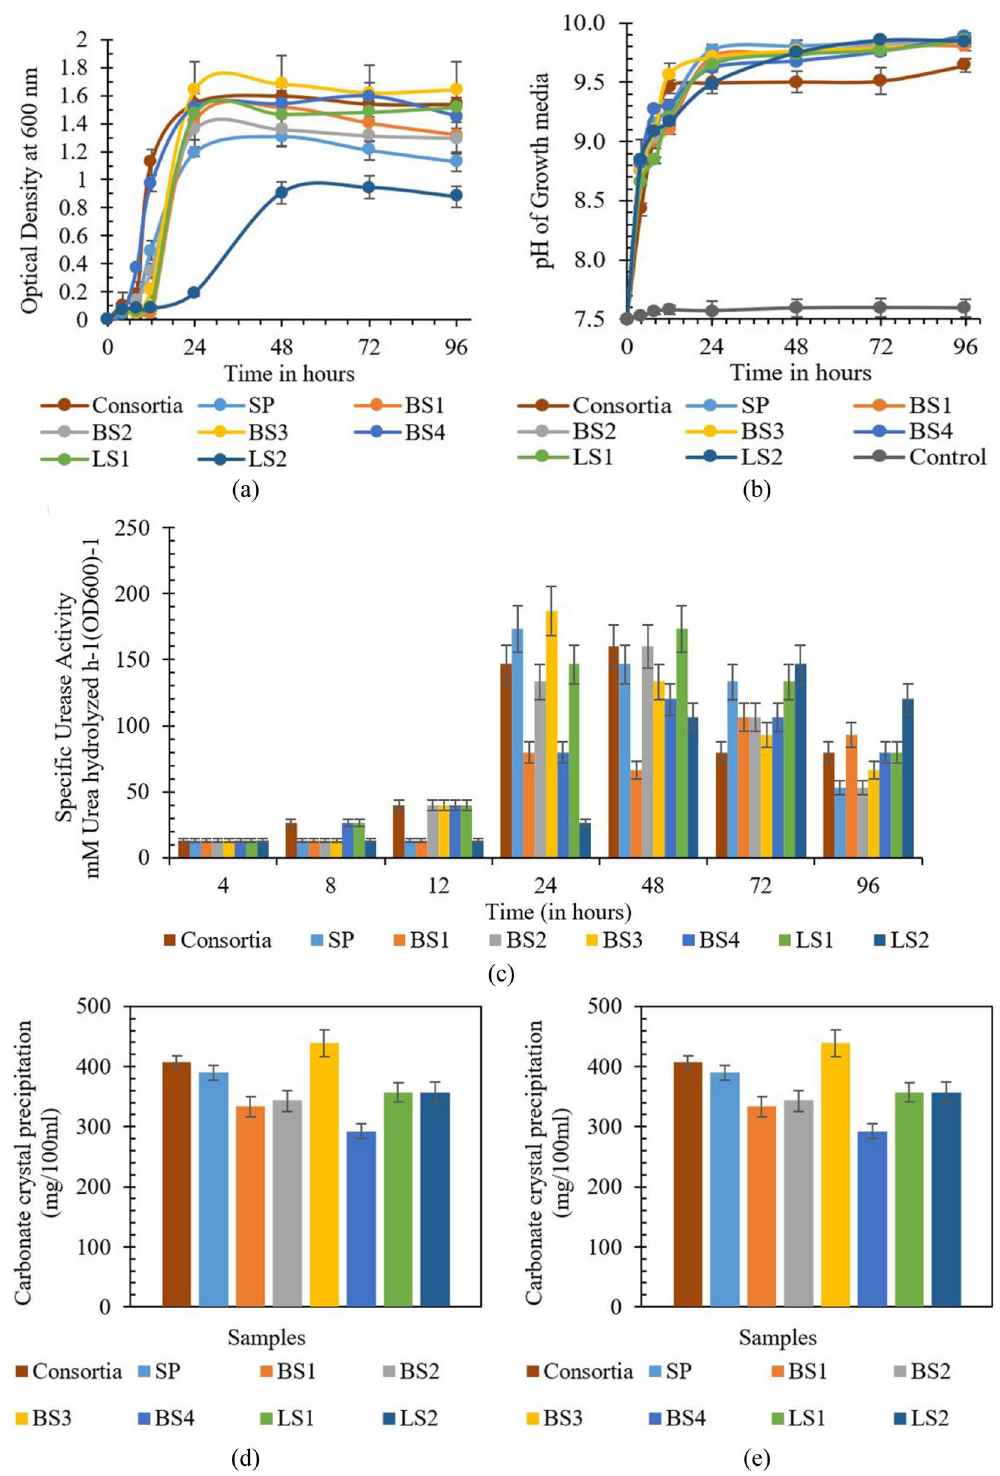
Figure 4. ( a ) Growth characteristics, ( b ) pH, ( c ) specific urease activity, ( d ) calcium utilization rate, and ( e ) carbonate precipitation rate of the isolates and